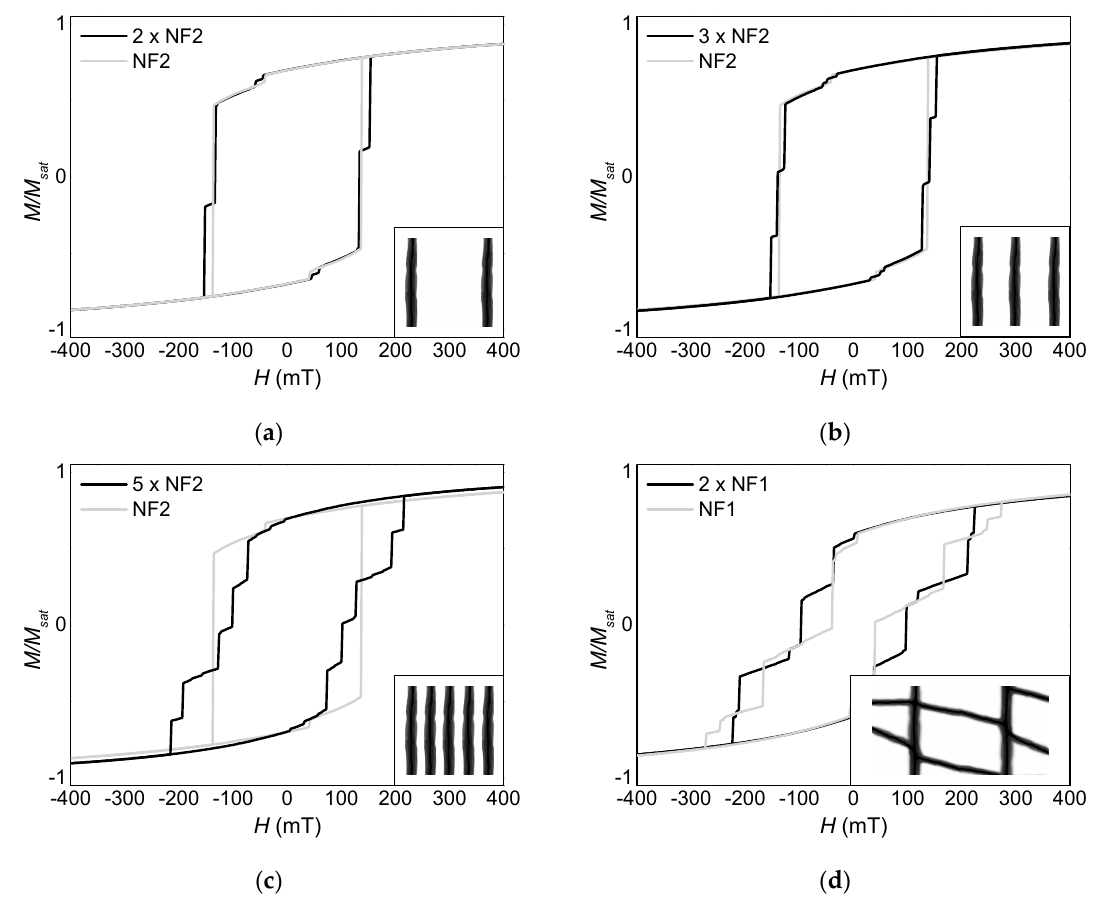
Figure 11. Influence of neighboring fibers in di ff erent distances on the magnetization reversal process, simulated for an angle of 45 ◦ and a thickness of 120 nm. ( a ) two neighboring fibers NF2, ( b ) three neighboring fibers NF2, ( c ) five neighboring fibers NF2, and ( d ) two adjacent fibers